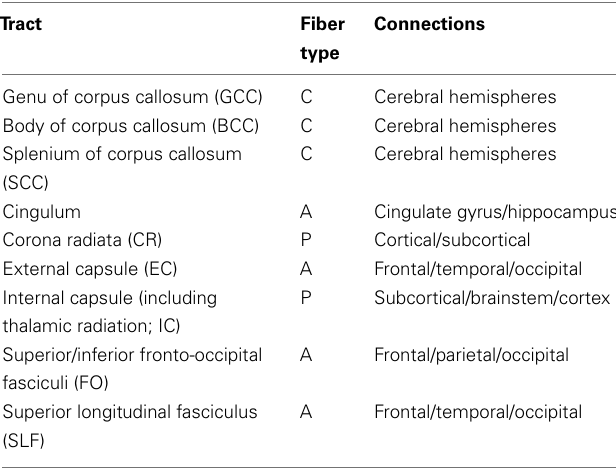
Table 1 | Cerebral white matter